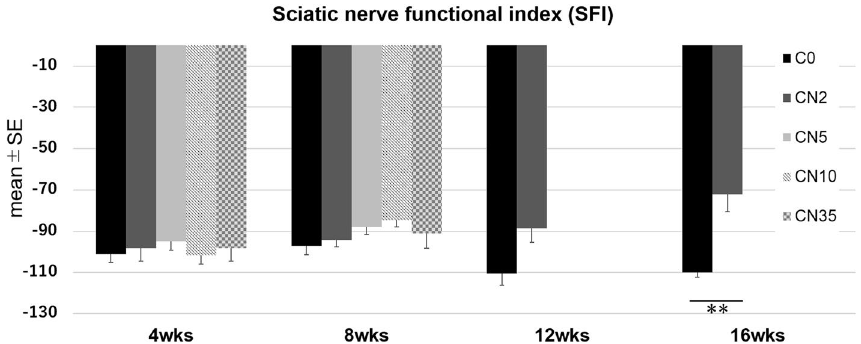
Figure 3. Results of the Sciatic nerve functional index (SFI). *** P < 0.001 (One-tailed ANOVA with Student t-test compared with C0).